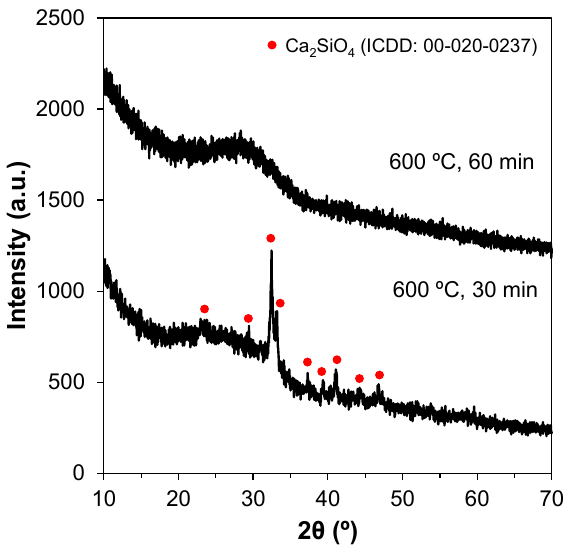
Figure 1. XRD patterns showing the effect of mixing times on the production of amorphous glasses via the sol–gel method. Changing the mixing period from 30 to 60 min produced amorphous glasses.